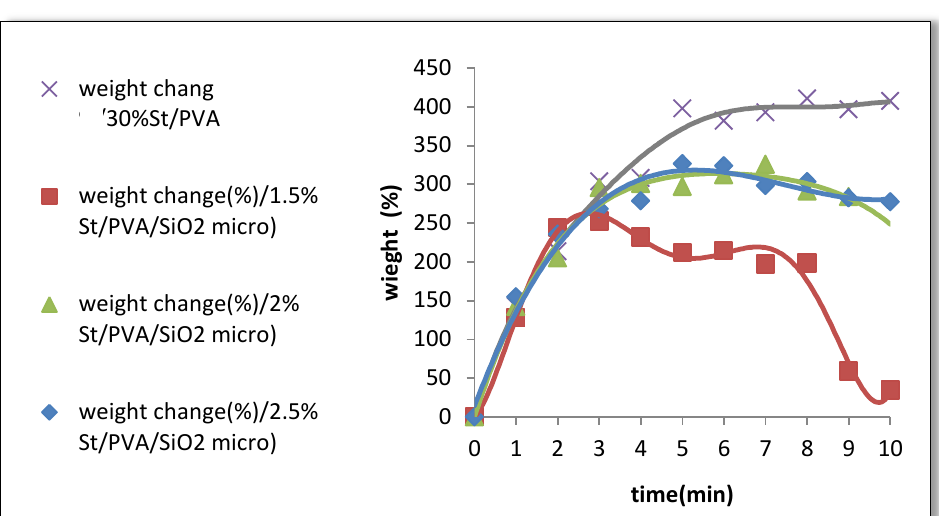
Fig. 2: Water absorption of micro SiO